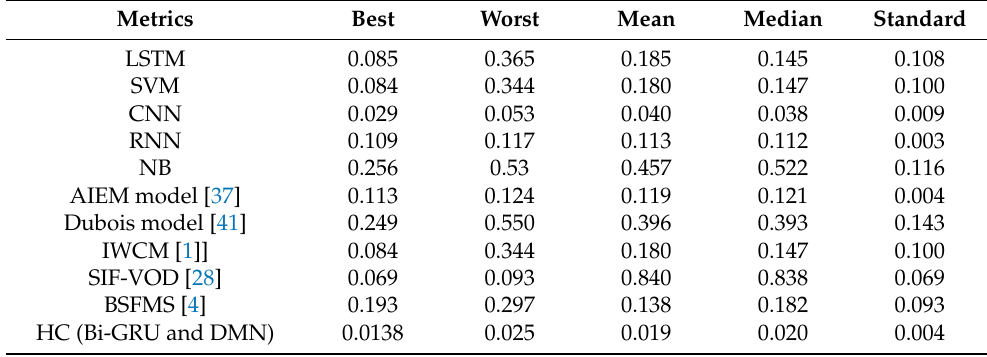
Table 1. Statistical